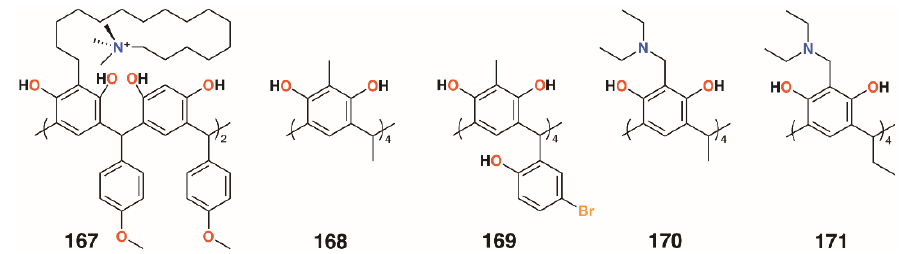
Figure 26. Resorcinarenes from the groups of Utomu, Yadav, Jumari, Yamin, and